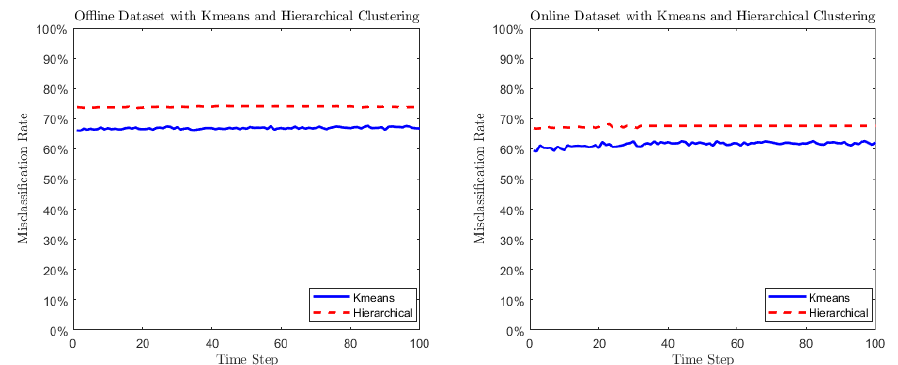
Figure 5. The functional form of H ( • ) follows Equation (74): H ( t ) = 0.5 + h i · sin ( π t /100 ) with t = 0,1, . . . ,100. The left graph plots the misclassification rates output by K -means and hierarchical clustering methods using the offline dataset. The right graph shows the misclassification rates using the online